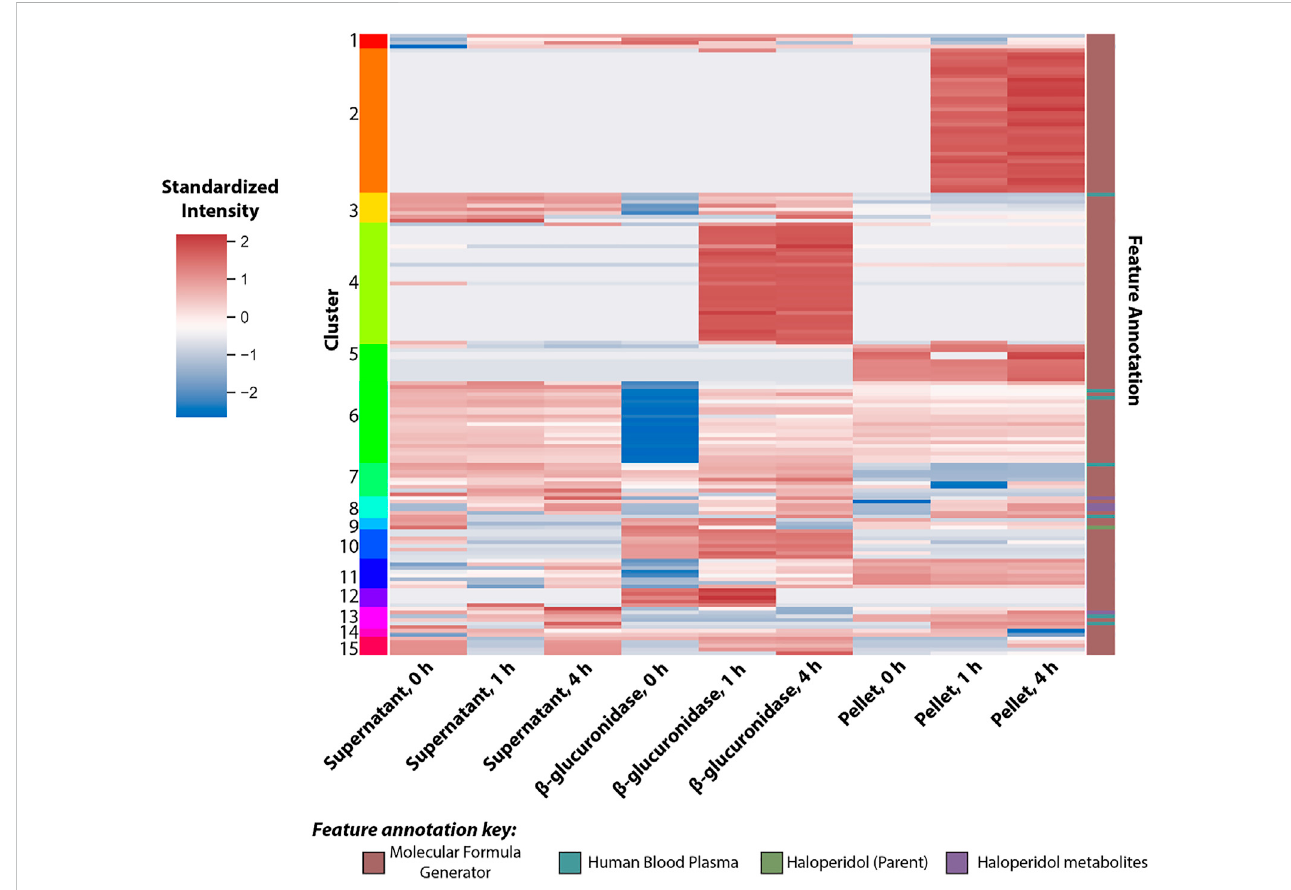
FIGURE 4 Heat map of features identi fi ed in the haloperidol dataset. Each row represents a single feature extracted from the MS 1 and standardized across all experimental conditions. Features were annotated using either Agilent ’ s molecular formula generator, a list of metabolites common to human blood plasma, or a list of metabolites related to haloperidol (including the parent structure). The annotation source for each feature is outlined by the right-most column. Features were also clustered into 15 groups (left-most column) based on their distribution across the experimental conditions via a K-means clustering